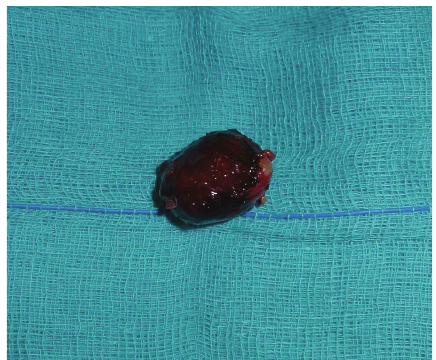
Figure 3: Macroscopy: the tumour mass appeared as a well-circum- scribed nodule of 2.0 × 1.5 cm, brown in